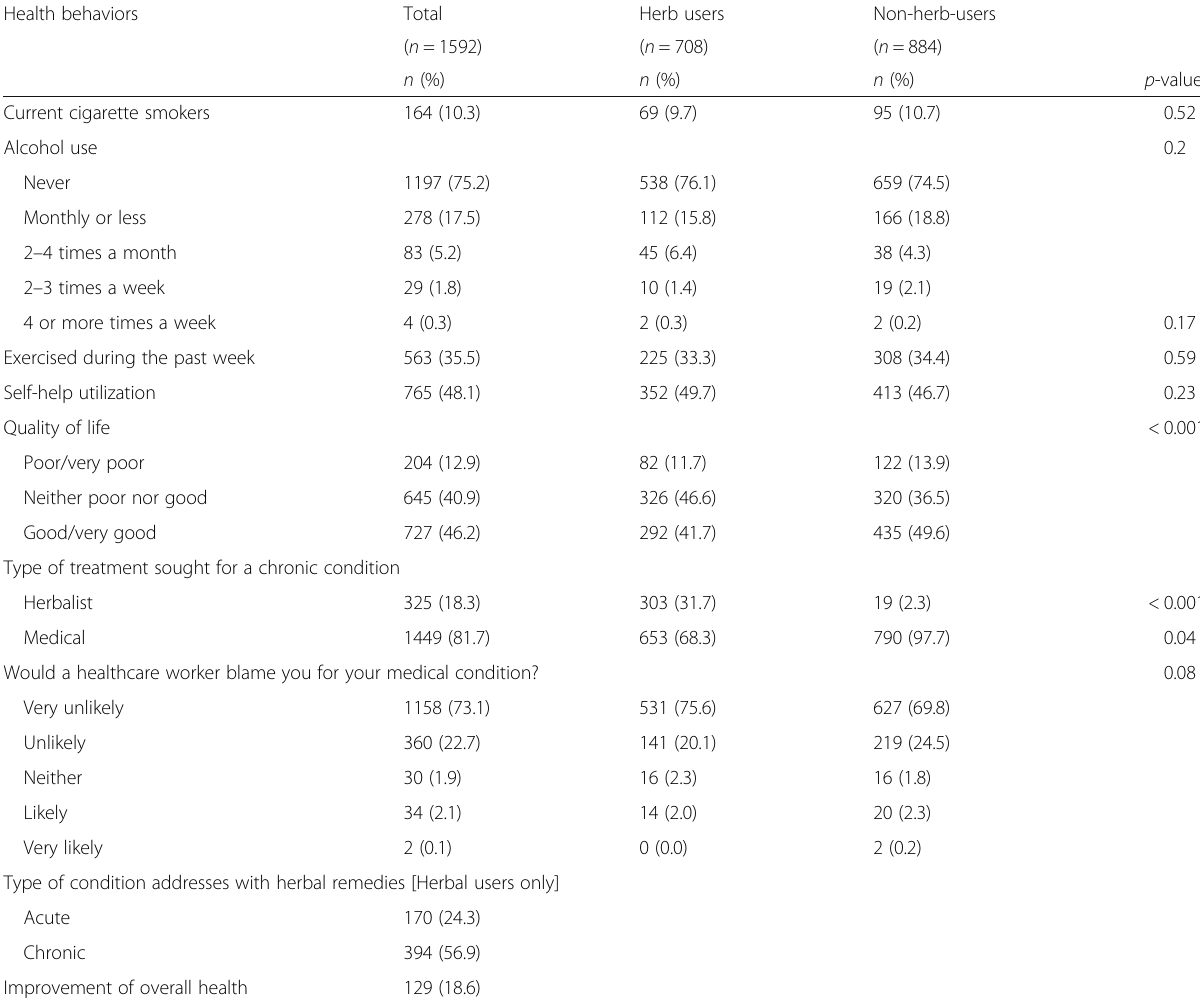
Table 2 Comparison of health behaviors among herb users and non-herb-users Health